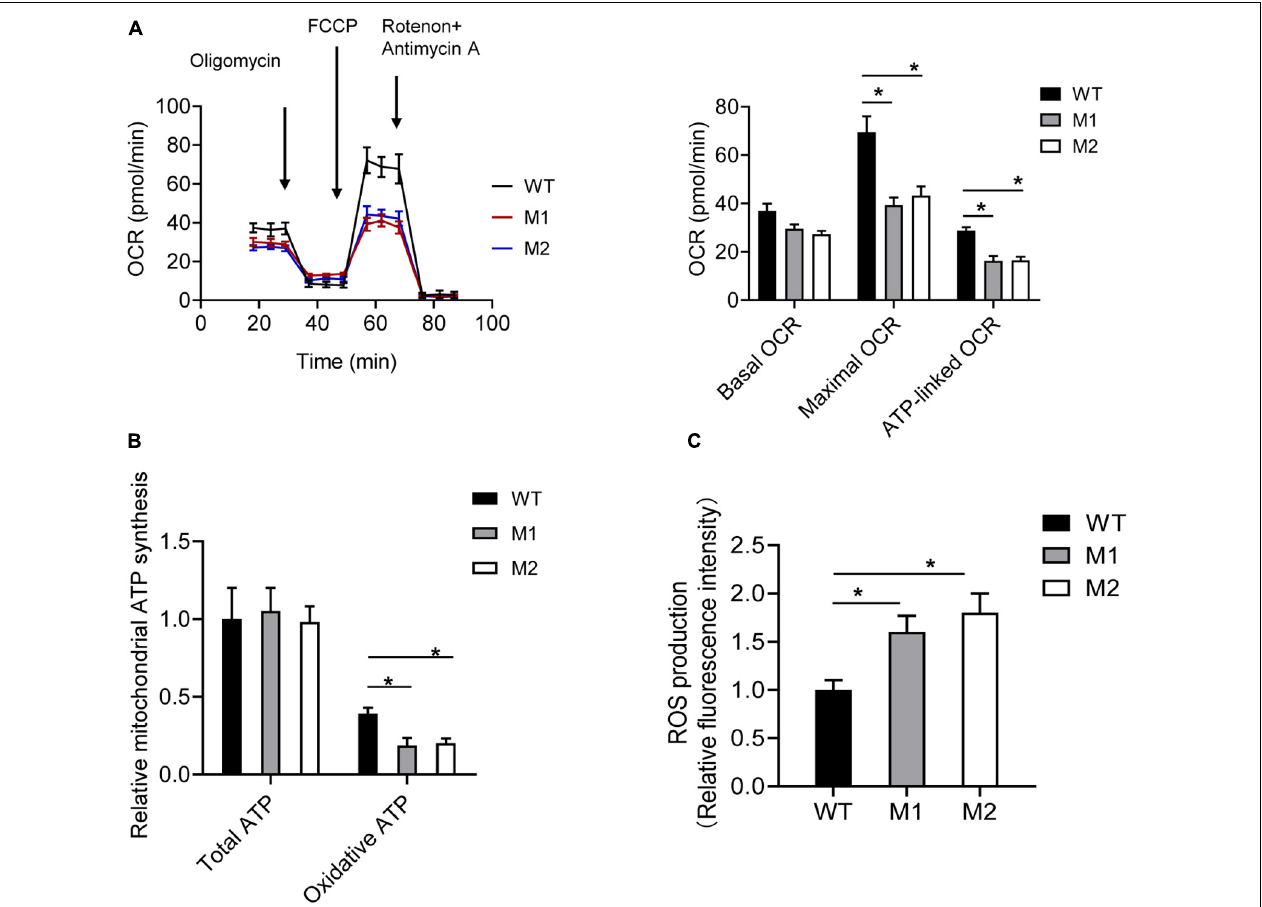
FIGURE 5 | The m.9396G > A variant results in mitochondrial dysfunction. (A) Analysis of OCR in WT (black), M1 (blue), and M2 (red) cybrids using the inhibitors oligomycin, FCCP, antimycin A, and rotenone. The basal OCR, maximal OCR, and ATP-linked OCR in cybrids WT, M1, and M2 are shown. Values are means ± SD. * p < 0.05 by one-way ANOVA. (B) Total and oxidative ATP levels in cybrids WT, M1, and M2. Values are means ± SD. * p < 0.05 by one-way ANOVA. (C) ROS production in cybrids WT, M1, and M2. Values are means ± SD. * p < 0.05 by one-way ANOVA.